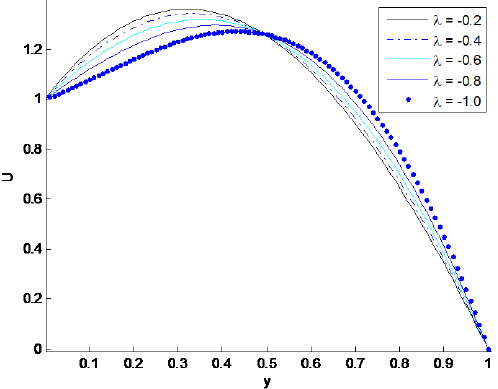
Figure 7: Temperature profile for different values of mixed convec- tion parameter Gre ( Br = 0.2 , S = 0.4 , λ = −0.3 , ε = −0.3 , d = 0.2 , q = 1 )